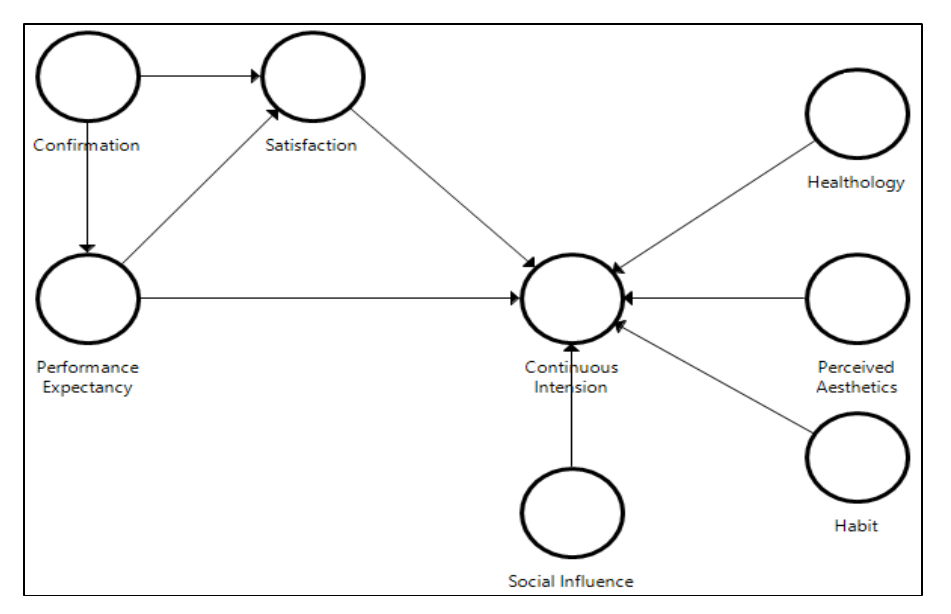
Fig. 1. The Research